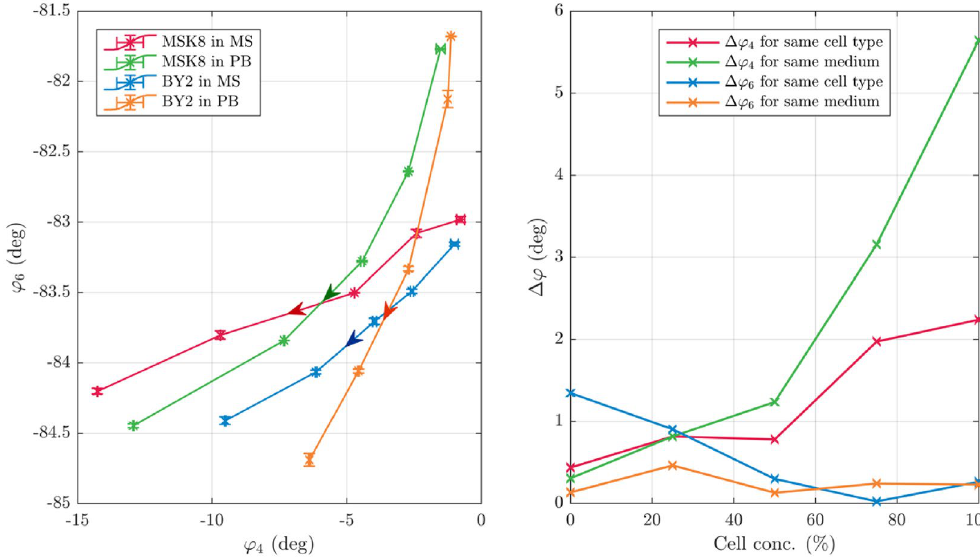
Figure 3. (left) ϕ 4 vs ϕ 6 for all four suspensions across the entire range of cell concentration, with the arrows indicating increasing cell concentration, and error bars indicating min–max bounds (right) mean deviation in ϕ 4 ( �ϕ 4 ) for all pairs of suspensions with the same cell-type, and for all pairs of suspensions with the same